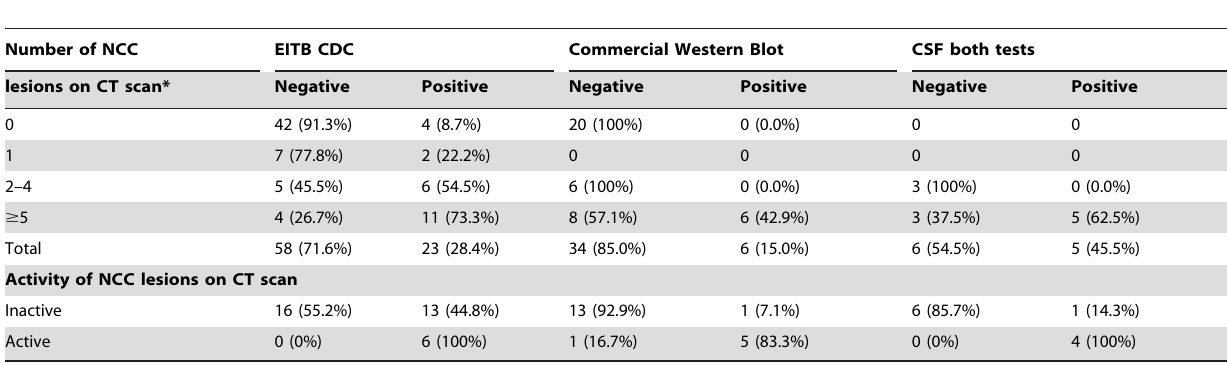
Table 4. Number and activity of neurocysticercosis lesions on cerebral computed tomography scan and cysticercosis antibody